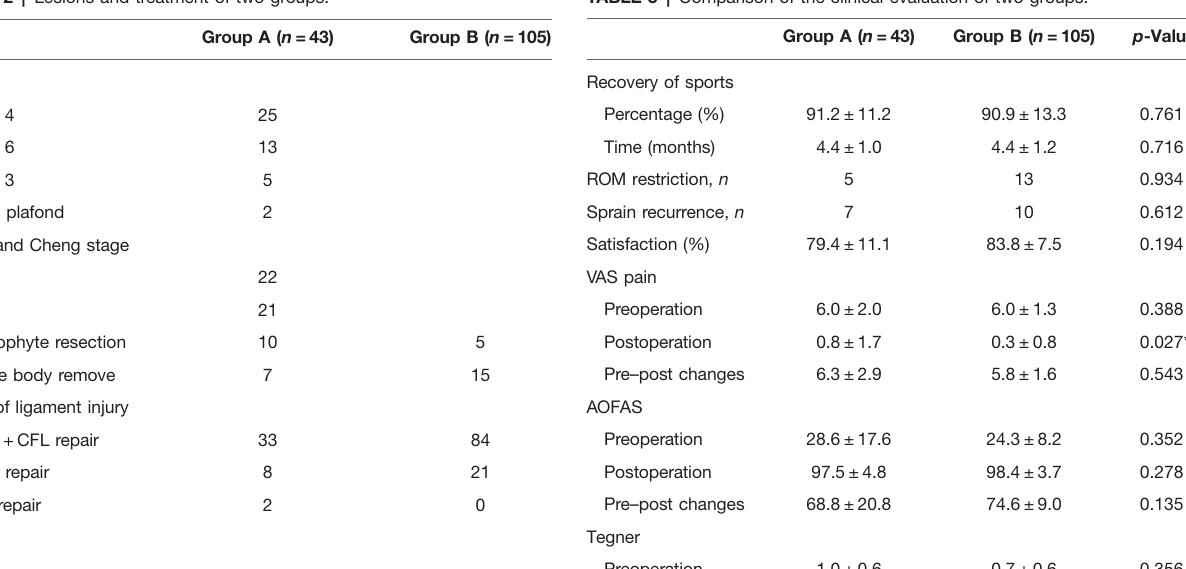
TABLE 2 | Lesions and treatment of two groups. TABLE 3 | Comparison of the clinical evaluation of two